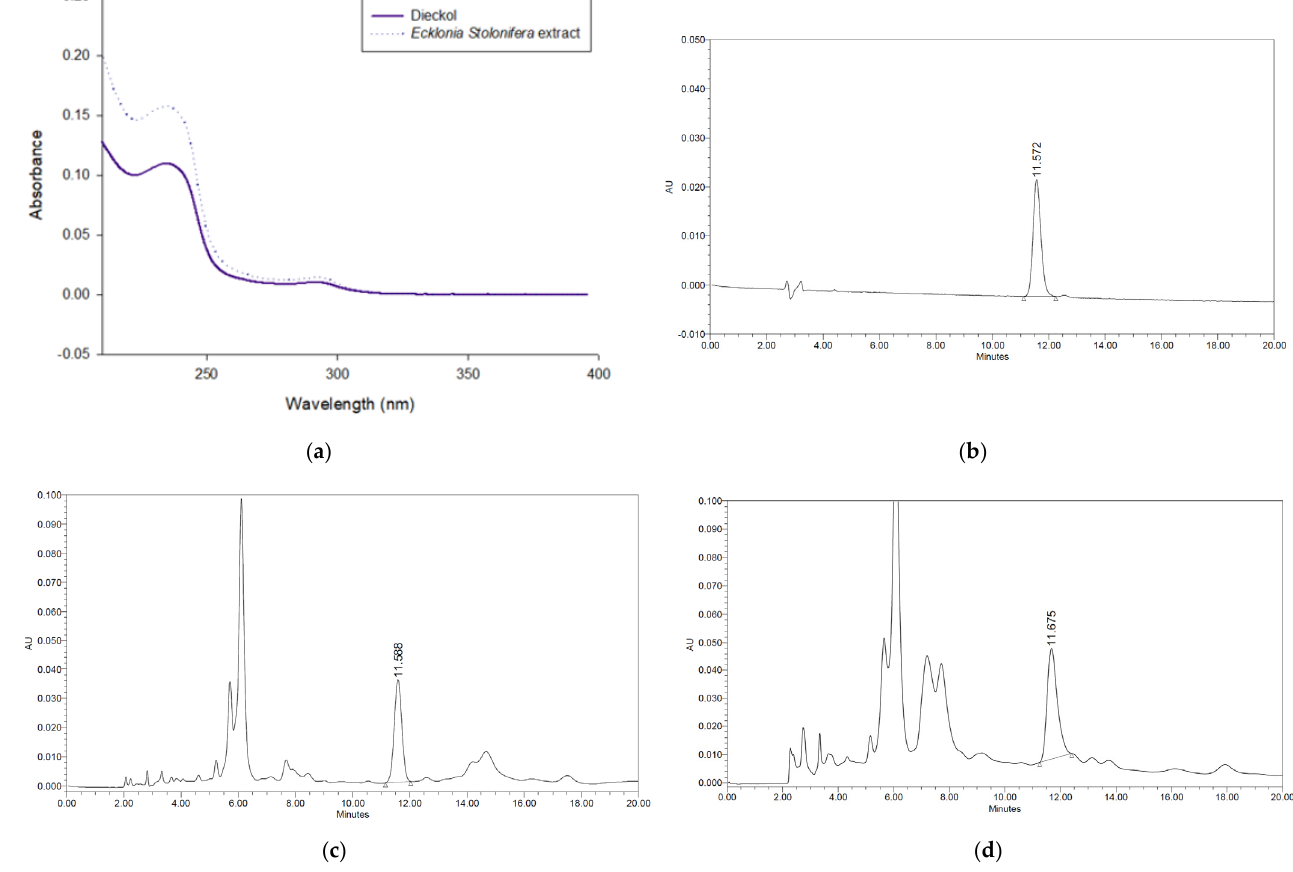
Figure 1. UV spectrums of dieckol ( a ); HPLC chromatogram of dieckol ( b ), ESE ( c ) and ESETM ( d ).